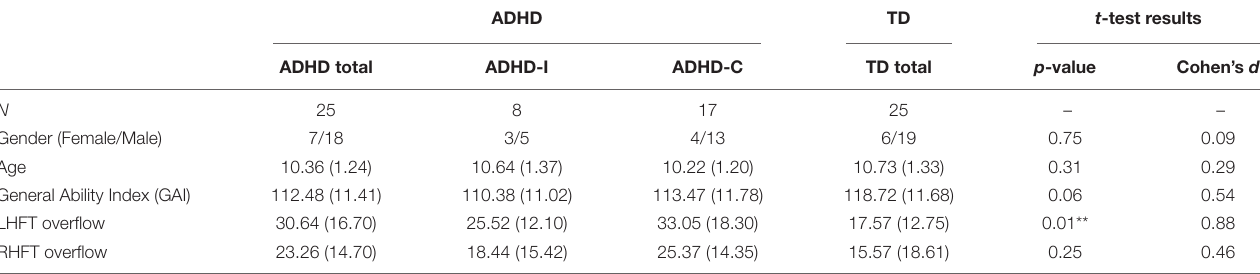
TABLE 1 | Demographics and behavioral results between children with ADHD and TD controls.